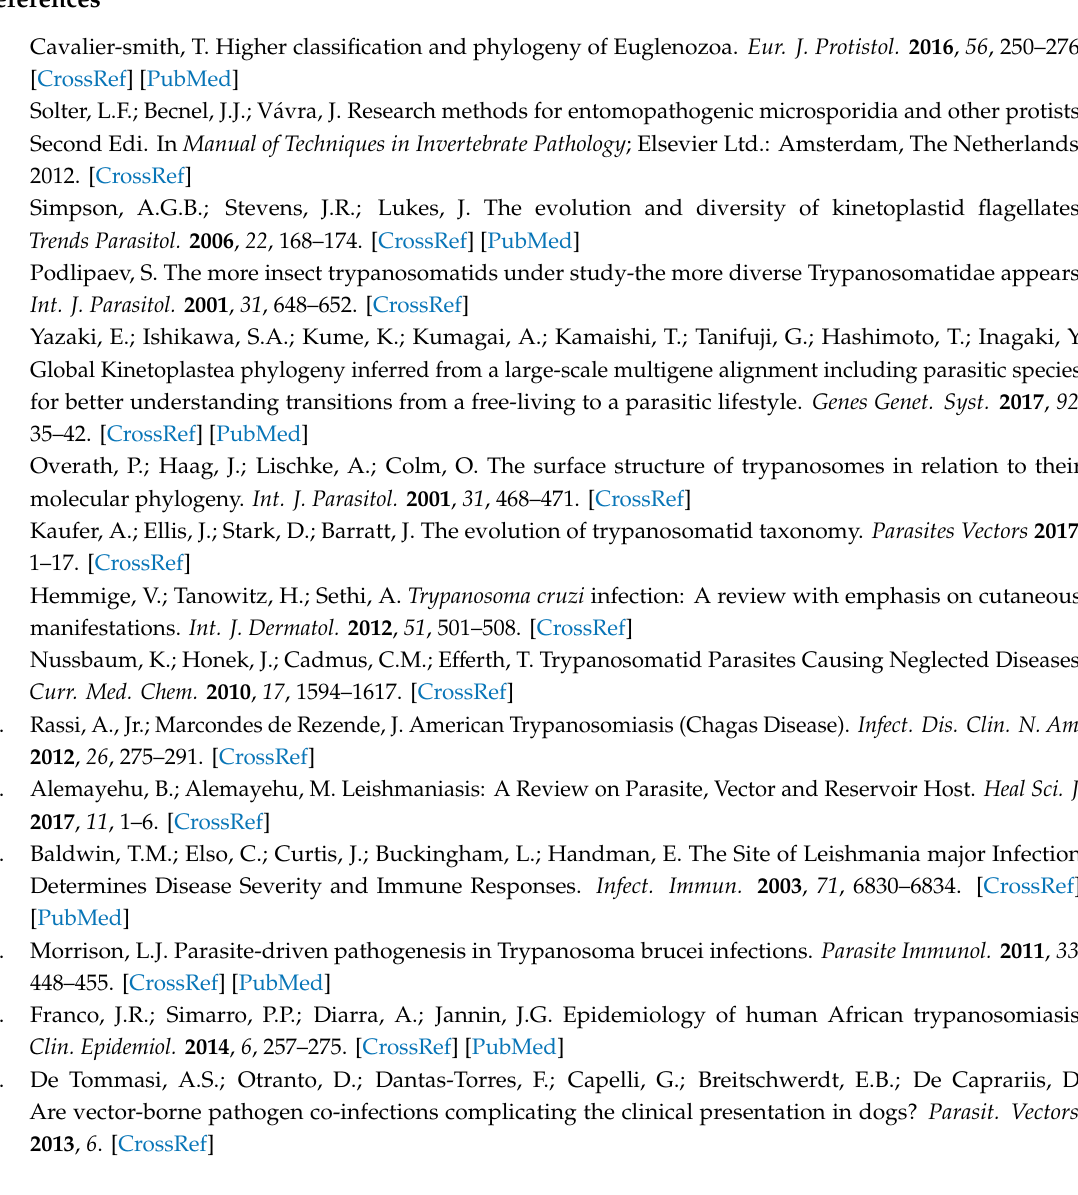
control DNA used for sensitivity and specificity determination of designed oligonucleotides, Table S2: Ct values repeatability and reproducibility of the real time qPCR assays, Table S3: Individual results for samples screened by the qPCR tools and